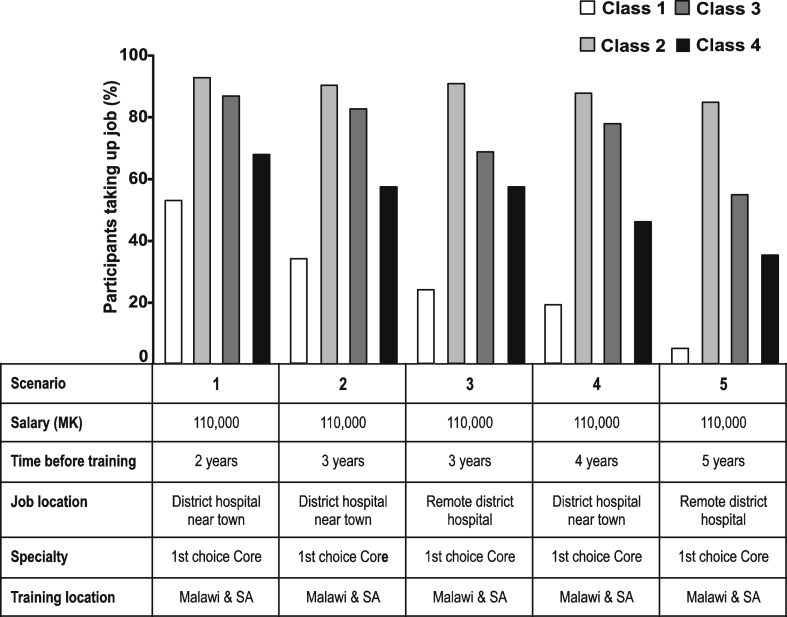
Maximising public sector service in exchange for preferred training. Scenario 1 represents a common training pathway in Malawi of two years working in a district hospital near town at basic salary before access to training in a preferred core specialty. Scenarios 2 to 5 simulate the impact of increasing lengths of mandatory service and remote location on job uptake. MWK = Malawian kwacha; SA = South Africa.